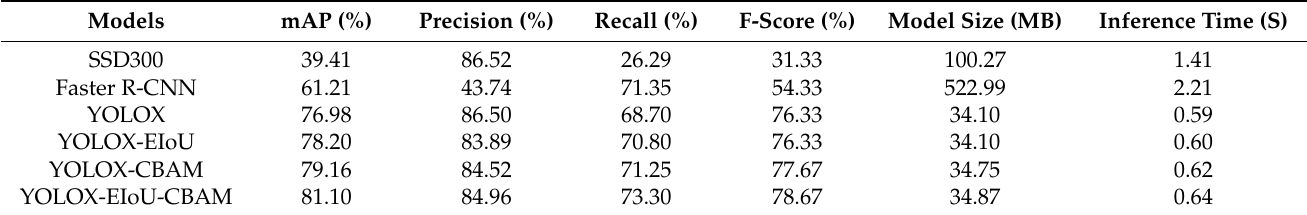
Table 2. Multi-metric performance evaluation (mAP, precision, recall, F-score, model size, and inference time) of six models (SSD300, Faster R-CNN, YOLOX, YOLOX-EIoU, YOLOX-CBAM, and YOLOX-EIoU-CBAM) on 240 test samples.